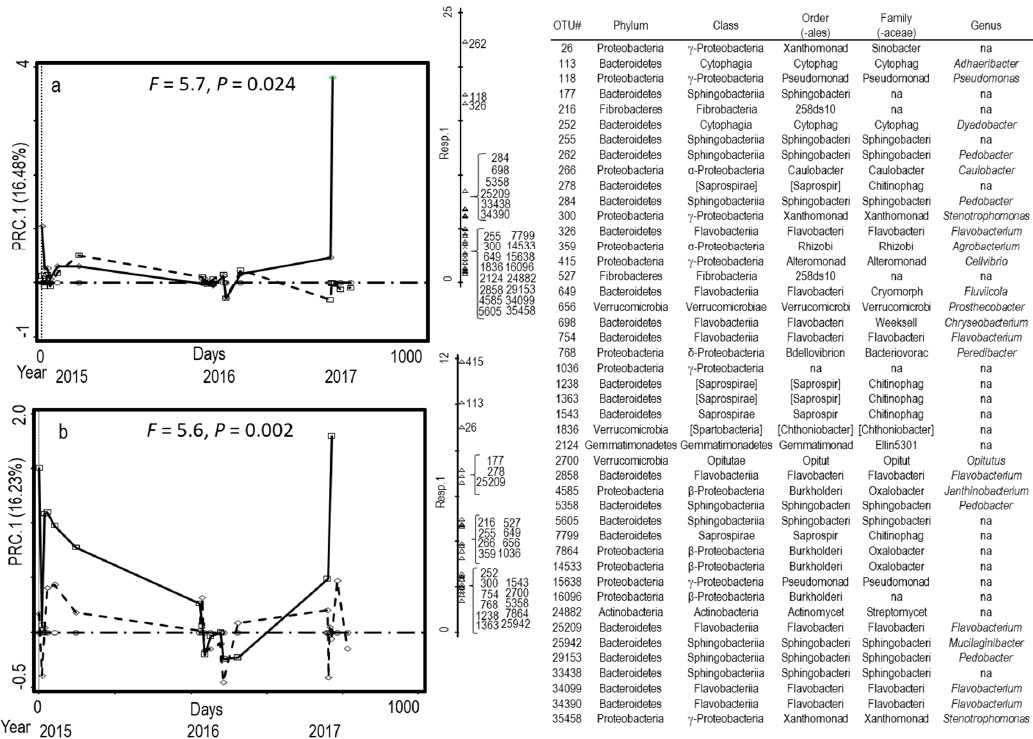
Figure 1. First principal response curve coefficient (PRC.1 with explained fitted variation in parentheses) of the 16S amplicon sequences for ( a ) Lilac and ( b ) Wheelock. Curves represent the deviation between a compost treatment (dashed: dairy manure; solid: poultry litter) from a non-amended control (dotted-dash) as a function of time, with 0 as the day of compost amendment in 2015 and the continuous calendar time until the end of the 2017 season. Symbols mark the sampling times. The weights of the 25 best-fit OTUs are shown on the right axis. Missing taxonomic information occurs if higher resolution was not available (na) for the OTU. Monte Carlo permutation tests permuting whole time series were applied to compute the statistical significance ( n = 186 for Lilac, 181 for Wheelock).